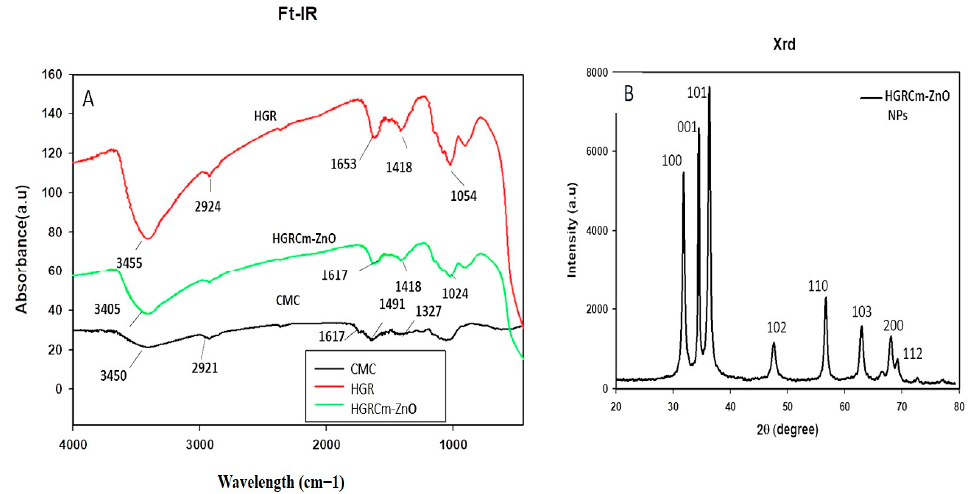
Figure 3. ( A ) Fourier transforms infrared analysis (FT-IR) for CMC (Black), hydroponic ginseng root (Red) and HGRCm-ZnO NPs (Green) and ( B ) XRD analysis of hydroponic ginseng root CMC-coated ZnO NPs (HGRCm-ZnO NPs (Black).